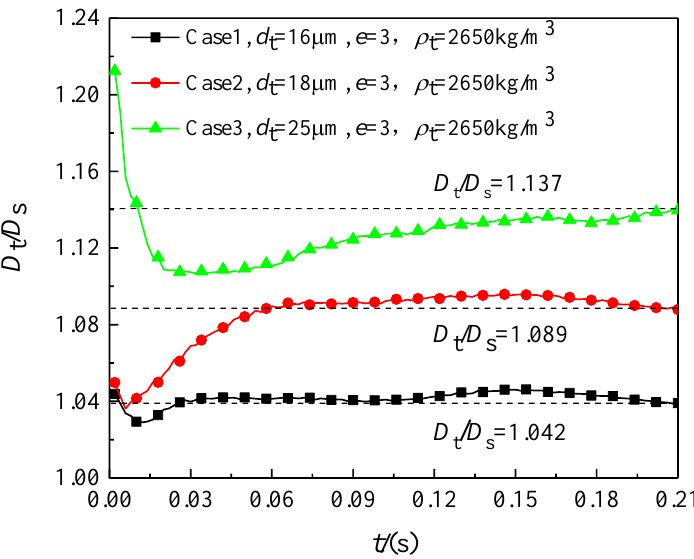
Figure 8. Variations of displacement ratio D t / D s between tracer and slurry particle with respect to time t under conditions of ρ t = 2650 kg/m 3 , e 0 = 3 and d t / d s = 1.6, 1.8 and 2.5.